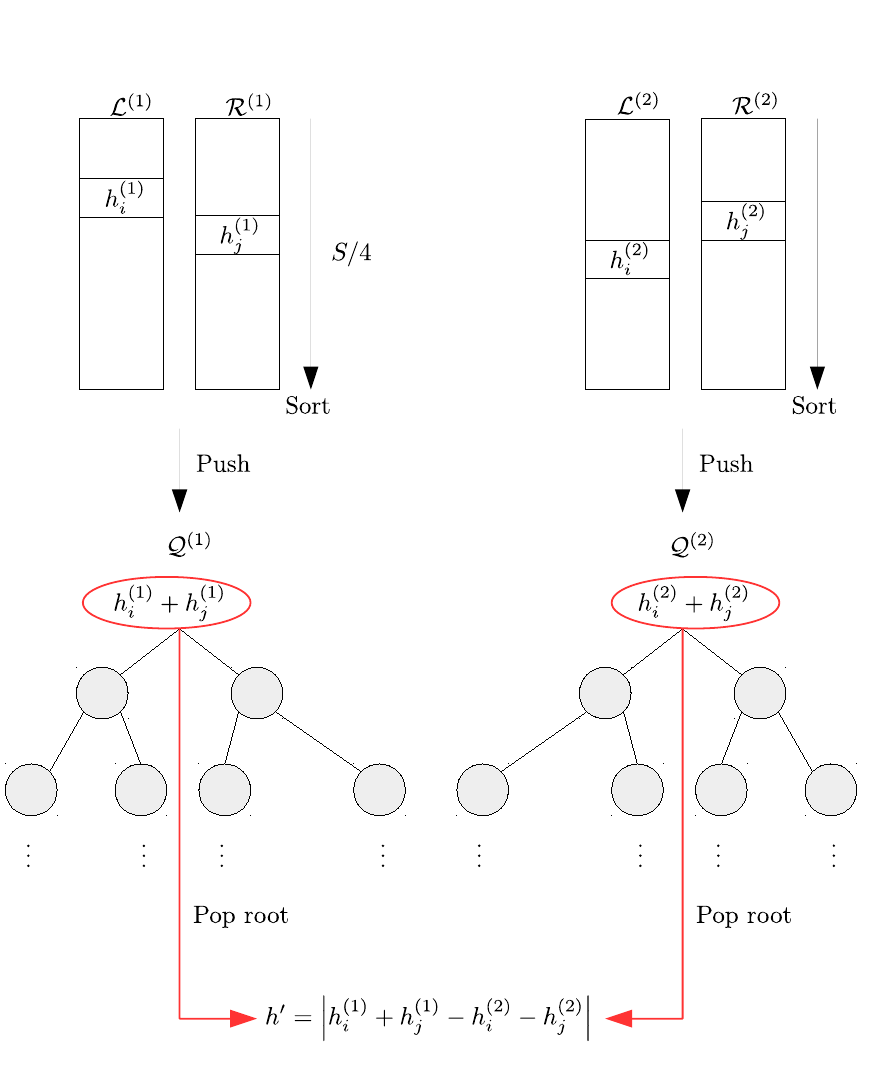
Figure 6: Overview of the Schroeppel–Shamir-based range reduction algorithm directly transformed from their original